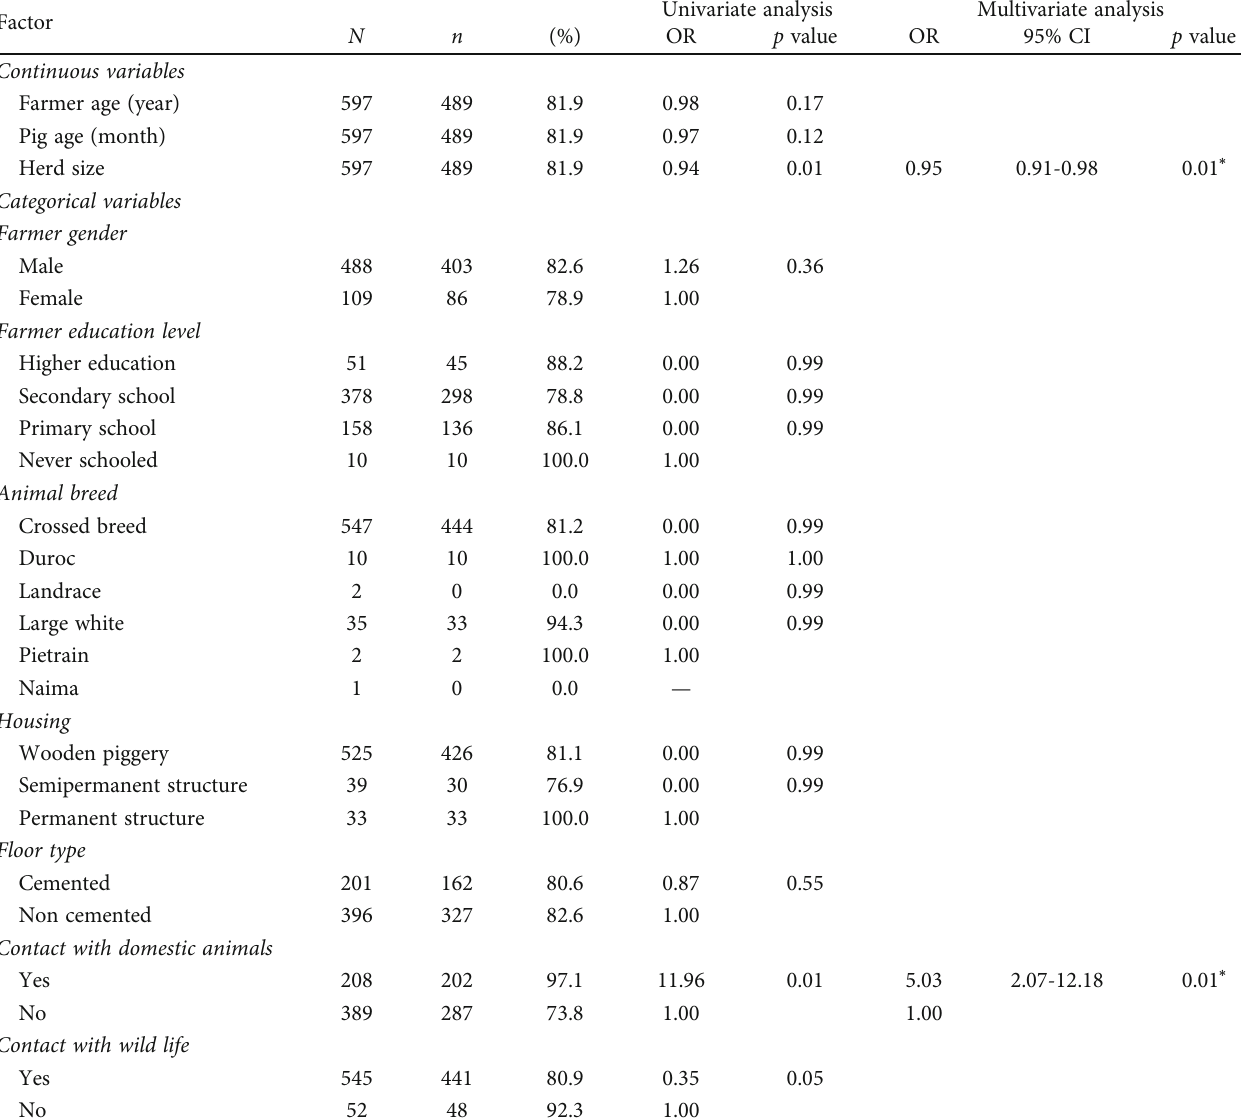
Table 3: Logistic regression analysis of risk factors for Hyostrongylus rubidus infection in pig farms in Menoua Division. Results are expressed in terms of odd ratio (OR) and 95% con fi dence interval